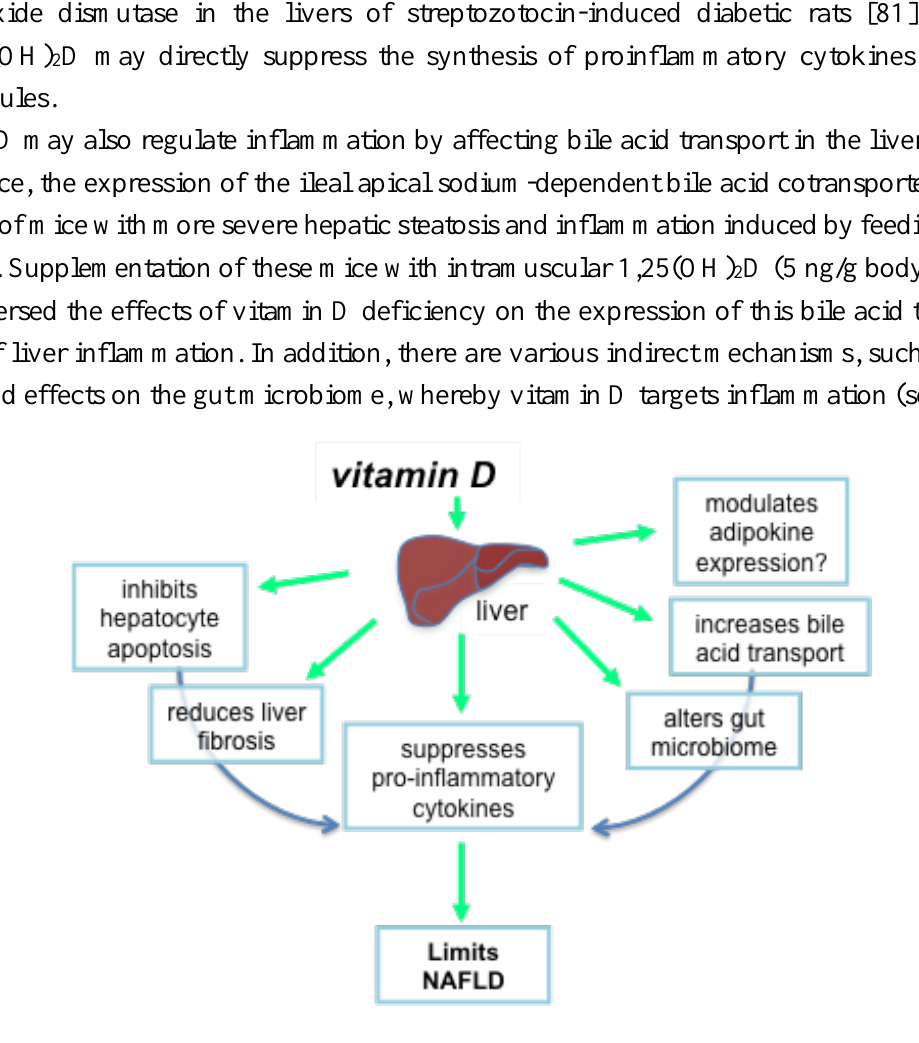
Figure 2. Vitamin D may limit the progression of non-alcoholic fatty liver disease through multiple, potentially interacting